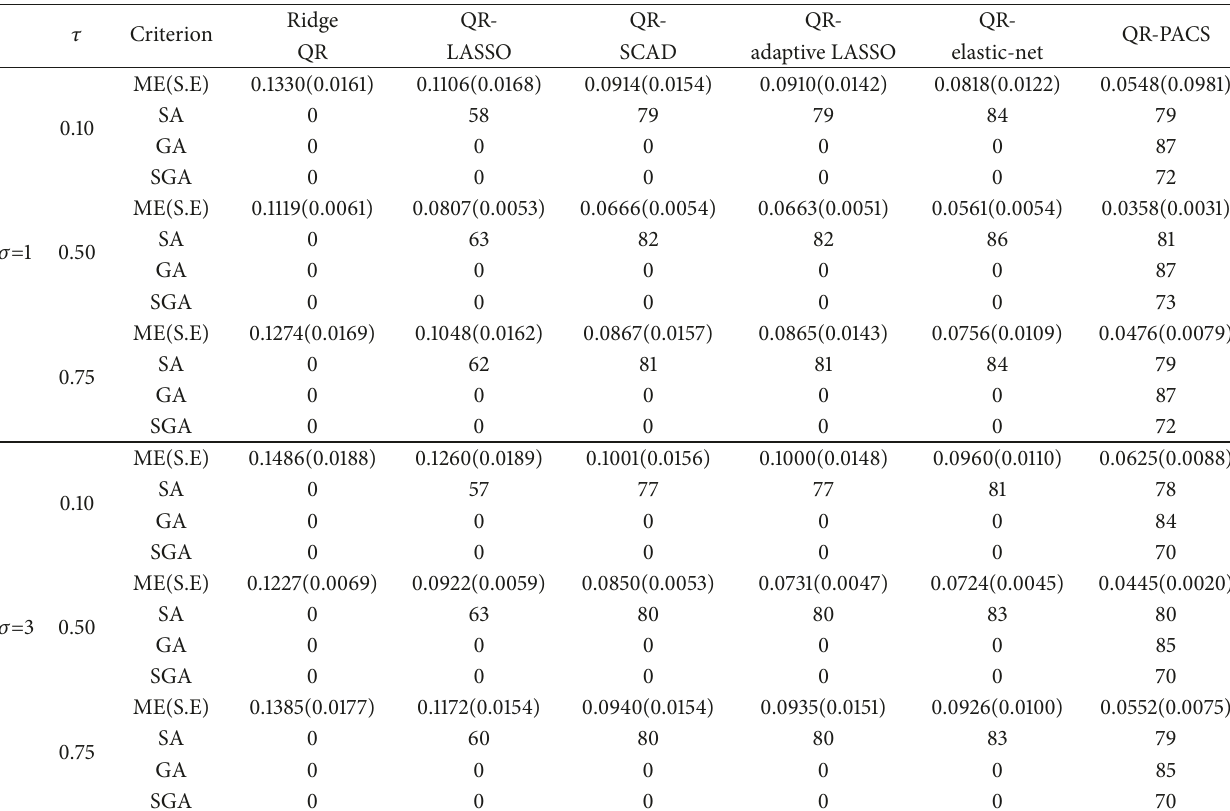
Table 5: ME, SA, GA, and SGA results of Example 5 for n=100.